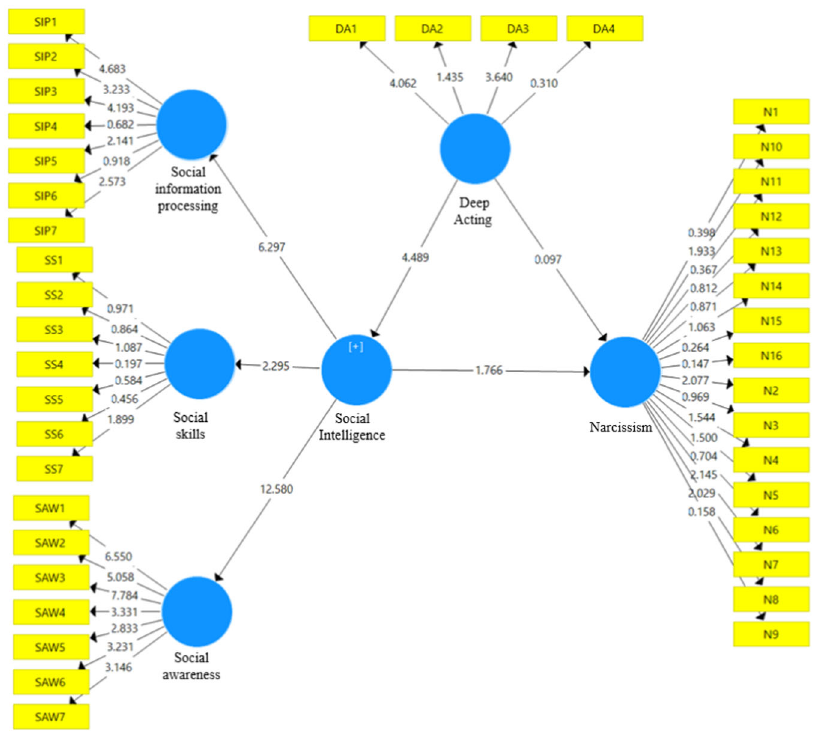
Fig. 3 Structural Equation Modelling Results (SEM) for testing hypotheses H2, H4, H5. Structural model